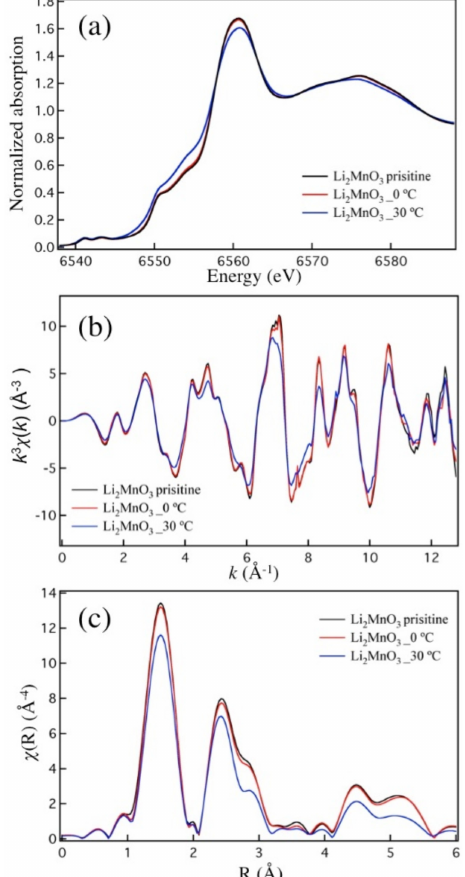
Figure 10. ( a ) Normalized Mn K-edge XANES spectra of Li 2 MnO 3 samples: pristine powder and electrodes after the 1st cycle (charge to 4.7 V, discharge to 2.0 V) at 0 ◦ C and 30 ◦ C, as indicated. The voltage profiles of these electrodes are shown in Figure 2a,b, respectively. ( b ) k 3 -weighted EXAFS χ (k) of Li 2 MnO 3 samples: pristine powder and electrodes after the 1st cycle (charge to 4.7 V, discharge to 2.0 V) at 0 ◦ C and 30 ◦ C, as indicated. The voltage profiles of these electrodes are shown in Figure 2a,b, respectively. ( c ) Fourier Transform magnitude of k 3 -weighted EXAFS data ( | χ (R) | ) of Li 2 MnO 3 samples (k-range: 2.5-11 Å − 1 ; R bkg :1.25